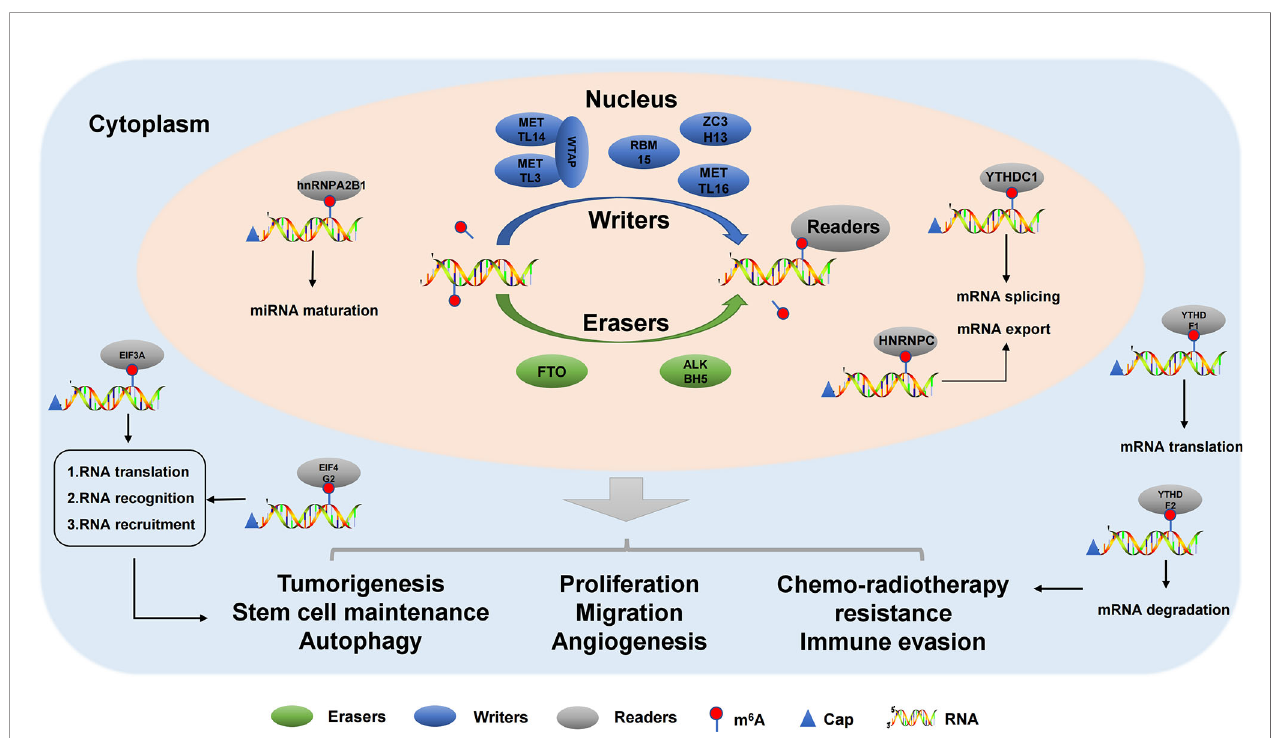
FIGURE 1 | The molecular mechanisms of m 6 A modi fi cation in cancers. m 6 A modi fi cation is a dynamic and reversible process. m 6 A methylation is catalysed by methyltransferase complex (writers), reversed by demethylases (erasers) and functionally facilitated by m 6 A-binding proteins (readers). m 6 A methylation participates in carcinogenesis and tumor